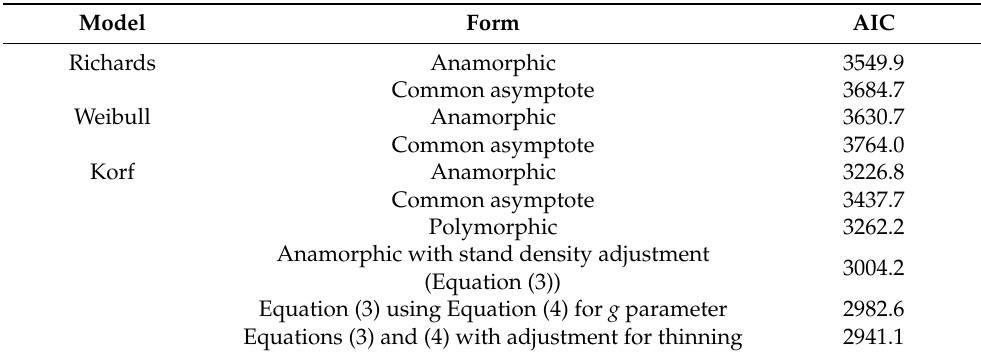
Table 5. Akaike Information Criterion (AIC) of nonlinear mixed models for predicting DBH from breast height age.